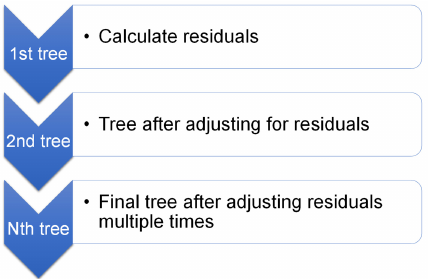
Figure 3. Graphical interpretation of gradient boosting model [76].